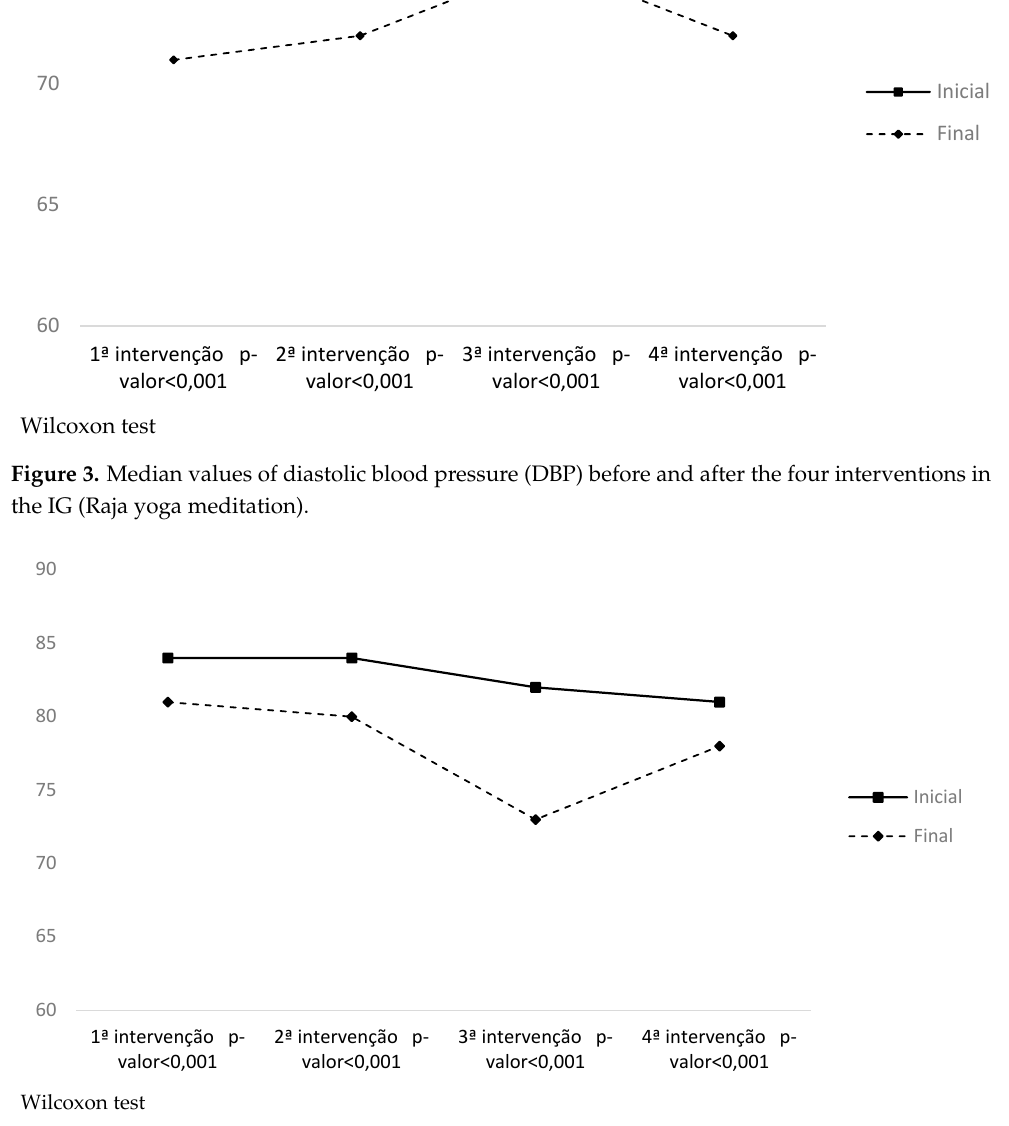
Figure 4. Median values of heart rate (HR) before and after the four interventions in the IG (Raja yoga meditation).